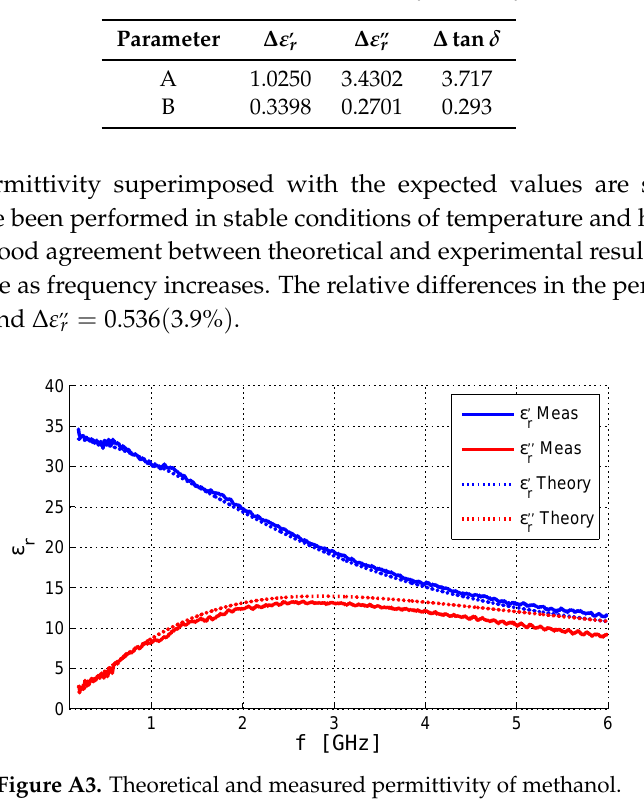
Table A2. Parameters of the uncertainty tendency lines.